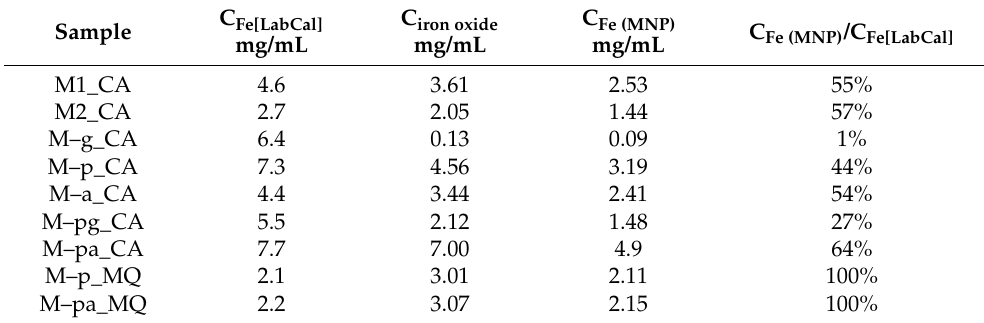
Table 9. Iron concentration determined using LabCal method, C Fe[LabCal] , and using the spontaneous magnetization, C Fe(MNP) . The corresponding ratio, C Fe (MNP) /C Fe[LabCal] , is also shown, as well as the magnetic iron oxide concentration, C iron oxide